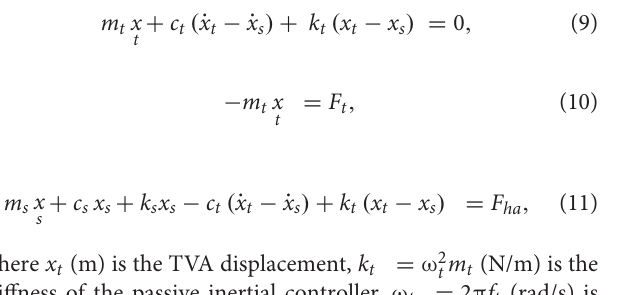
its circular natural frequency, f t (Hz) is the respective natural frequency, m t (kg) is the mass of the device, c t = 2 ω t m t ζ t (Ns/m) is the viscous damping of the device, and ζ t is the TVA damping